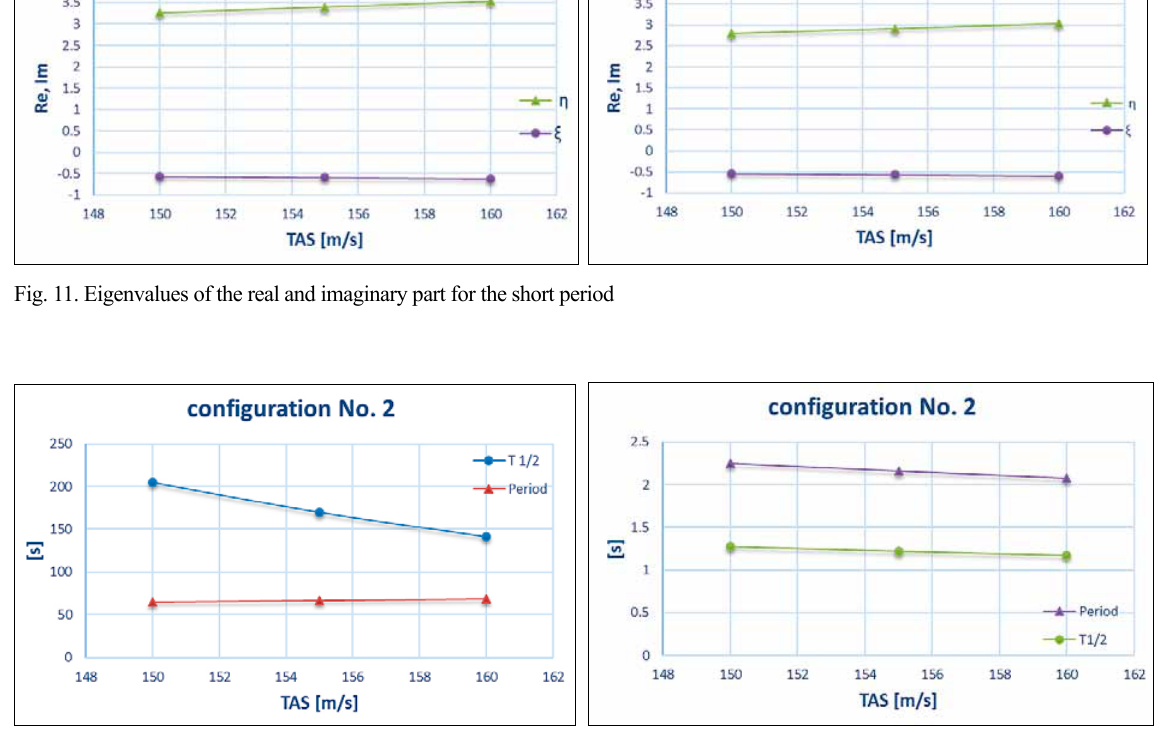
Fig. 12. The period and time to half damping for the phugoid (on the left) and short period (on the